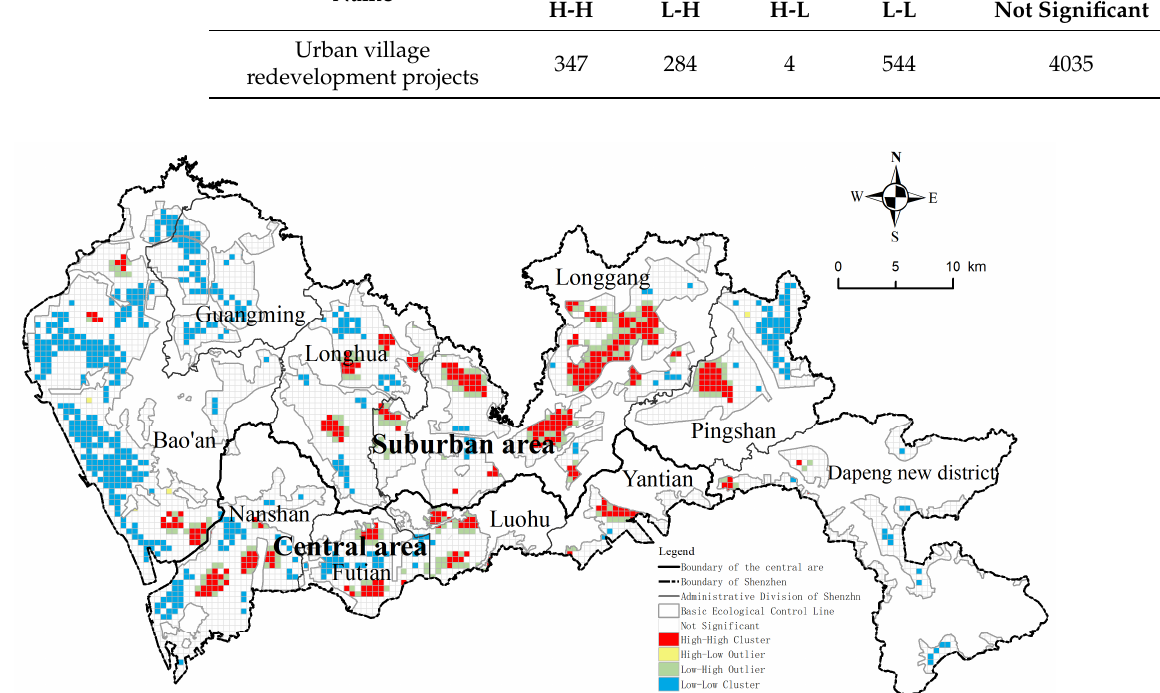
Table 3. Results of Local Moran’s I.